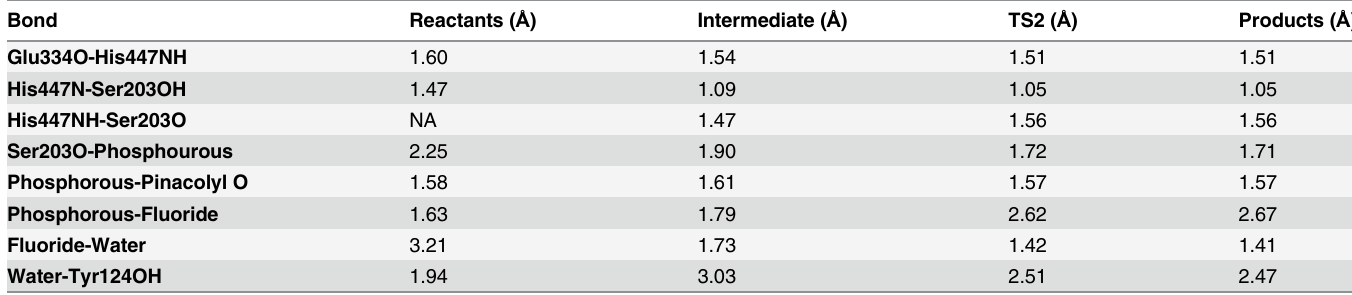
Table 1. Key bond lengths for atoms involved in the QM/MM